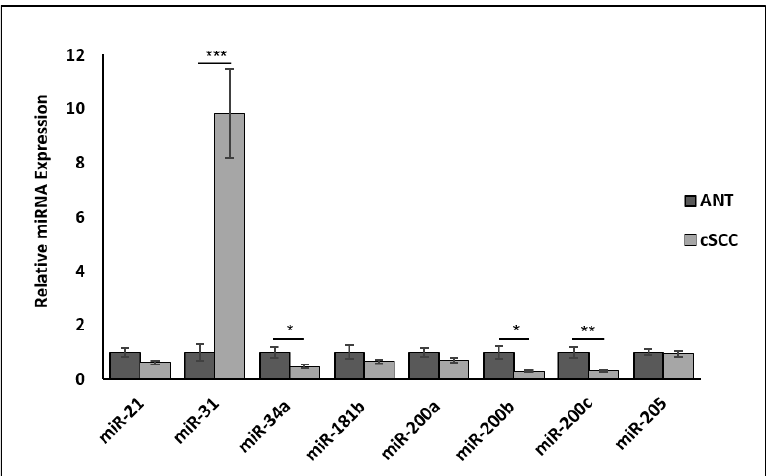
Figure 8. Differential expression of four oncogenic and EMT-related miRNAs between ANT and cSCC tissues. * denotes p < 0.05, ** denotes p < 0.01, and *** denotes p < 0.001.